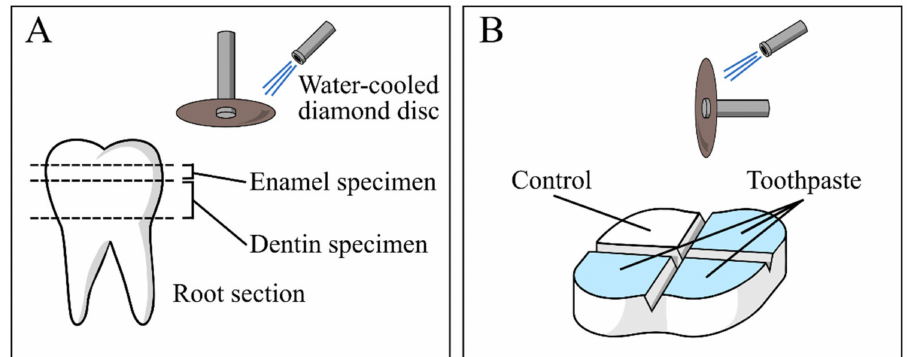
Figure 1. Schematic representation of specimen preparation: ( A ) horizontal sections of tooth in order to expose enamel and dentin and ( B ) delimitation of control and treatment